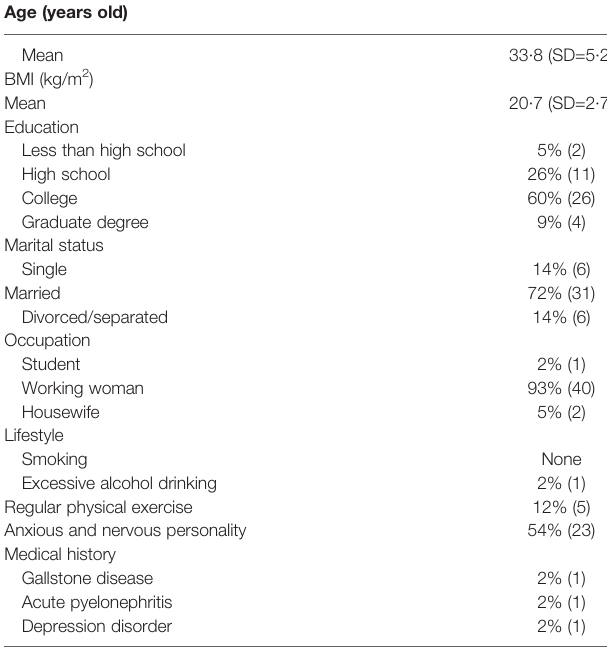
TABLE 1 | Baseline characteristics